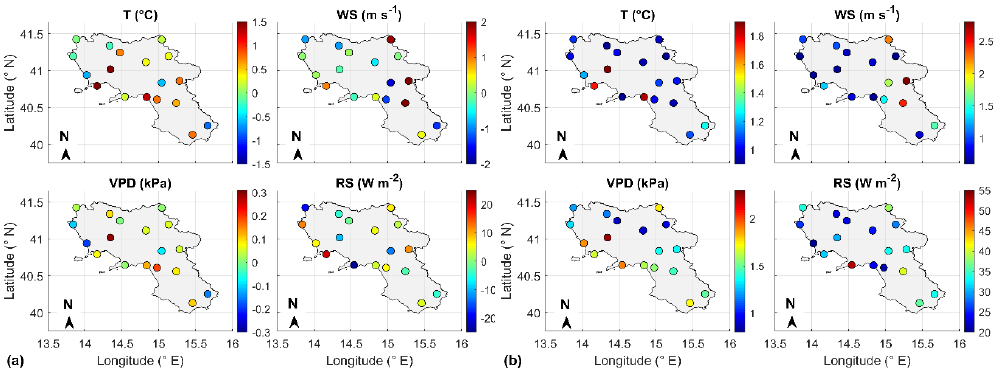
Figure 3. Statistical performance of the kriging estimator by cross ‐ validation: ( a ) BIAS; ( b ) RMSE.